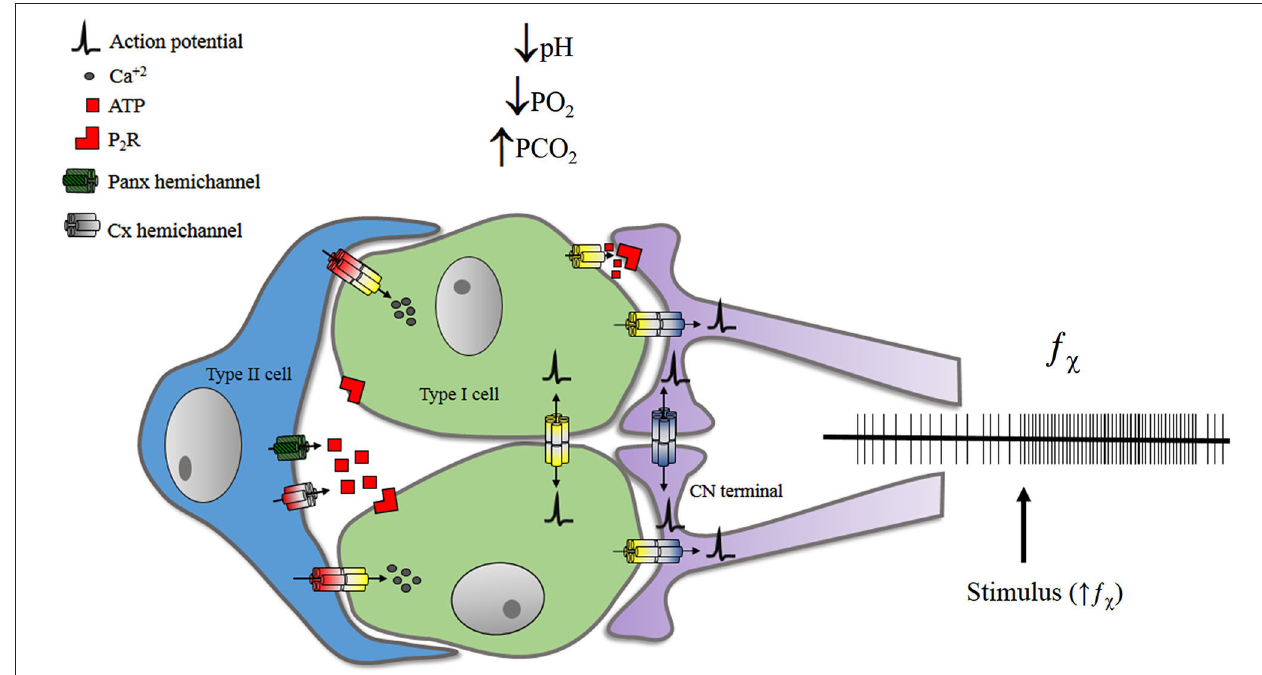
CN terminals. The release of ATP—from glomus and/or sustentacular cells—may also influence the chemosensory discharge of the carotid nerve. Details are discussed in the text. Chemical synapses are not